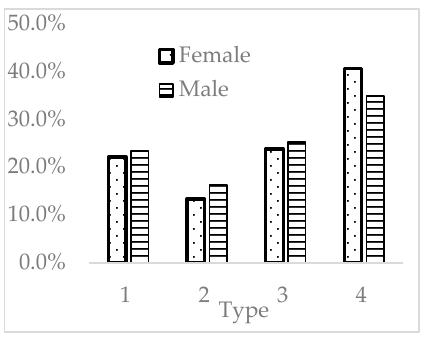
Figure 2. Distribution of females and males in the 4 types.